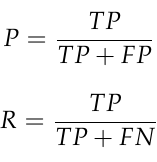
Figure 11. The calculation formulas for each parameter are as